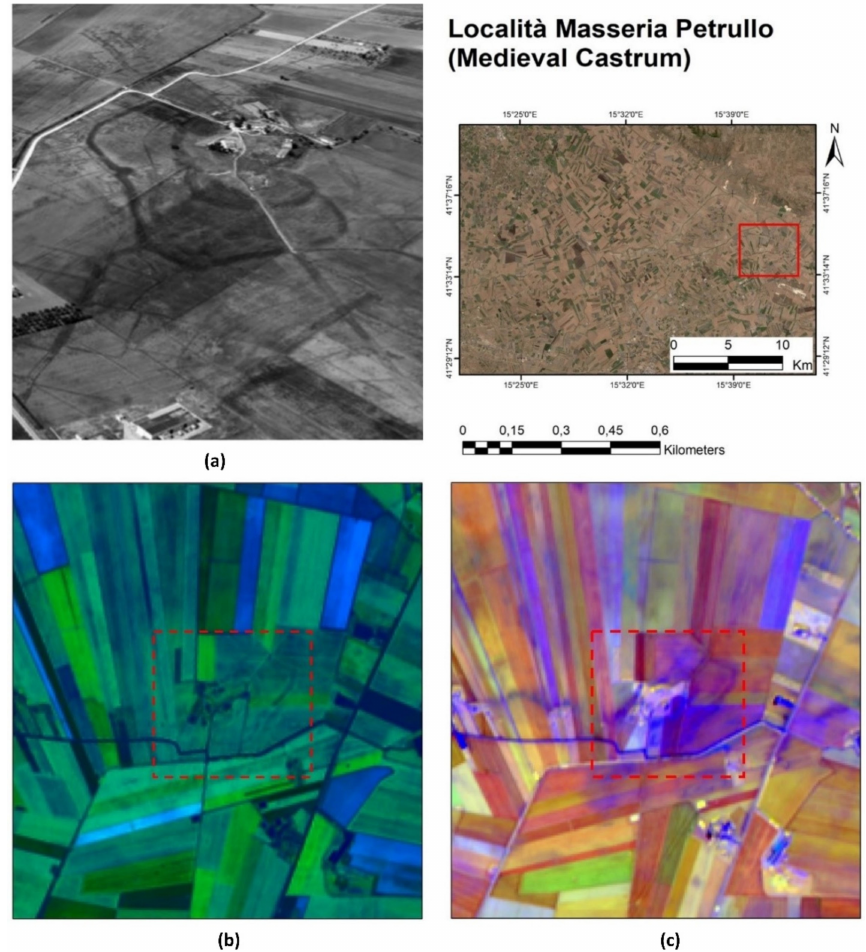
Figure 12. Archaeological Site of Masseria Petrullo (Medieval Castrum): ( a ) Aerial photo [43], Figure 6; ( b ) PCA obtained with all the bands and indices produced, R: 2nd component, G: 10th component, B: 11th component; ( c ) PCA obtained with the images in which Spectral Unmixing has shown greater separability, R: 1st component, G: 2nd component, B: 3rd component.